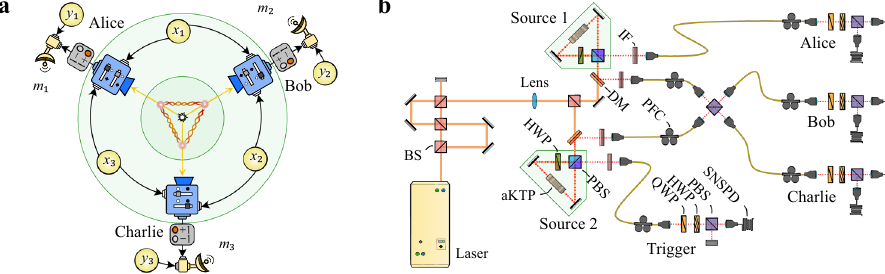
Fig. 2 Experimental layout. a Conceptual layout of the three-user GYNI protocol. The tripartite GHZ state is distributed among the three users who locally measure their photon based on input bits { x i , x j }. To compute the target function, each user broadcasts a one-bit message using their measured outcome and a local bit, y i . b We create the GHZ state using two polarisation-entangled photon-pair sources and a linear-optics fusion gate. Each source is implemented with an aperiodically poled KTP crystal embedded in a Sagnac loop that is optically pumped bidirectionally using a picosecond mode-locked laser, see Methods for details. Down-converted photons are separated from the pump laser using dichroic mirrors (DM) and interference fi lters (IF) then fi bre coupled into single mode fi bres. One photon from each source non-classically interferes on a polarising beamsplitter (PBS) creating the three-photon GHZ state conditioned on measuring the forth photon as a Trigger. Each user performs projective measurements on their qubit using a quarter-wave plate (QWP), half-wave plate (HWP), and PBS. Single photons are detected using superconducting nanowire single-photon detectors (SNSPD) and time-tagged for coincidence measurements within a 1 ns